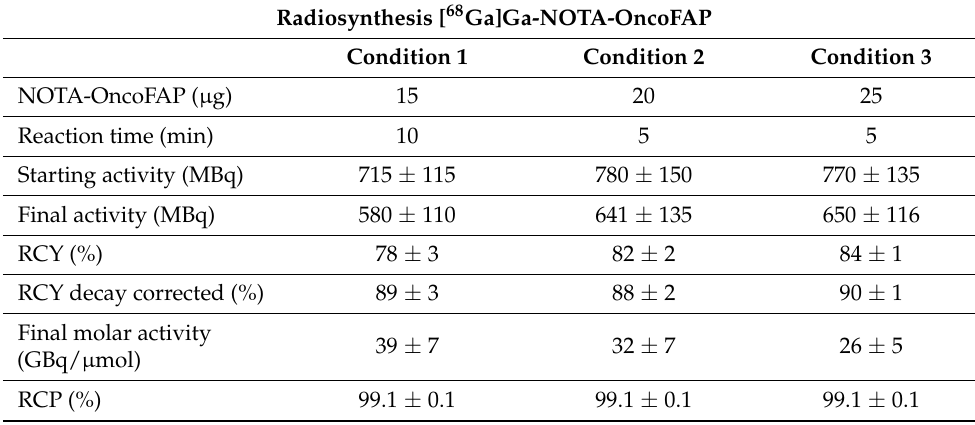
Table 1. Different synthetic conditions used for [ 68 Ga]Ga-NOTA-OncoFAP.